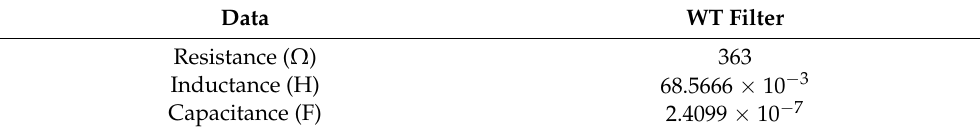
Table A3. Wind turbine harmonic